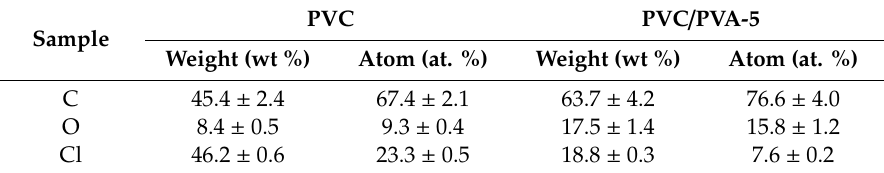
Table 3. The EDS results of PVC and PVC/PVA-5.